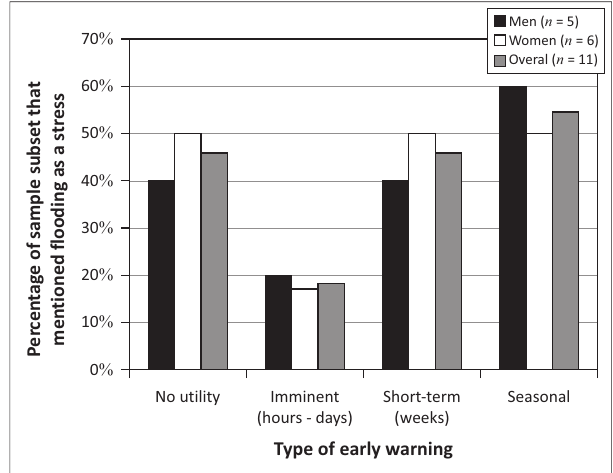
FIGURE 19: Answers of those in Group C who were asked what kinds of early warning would be useful, broken up by gender.